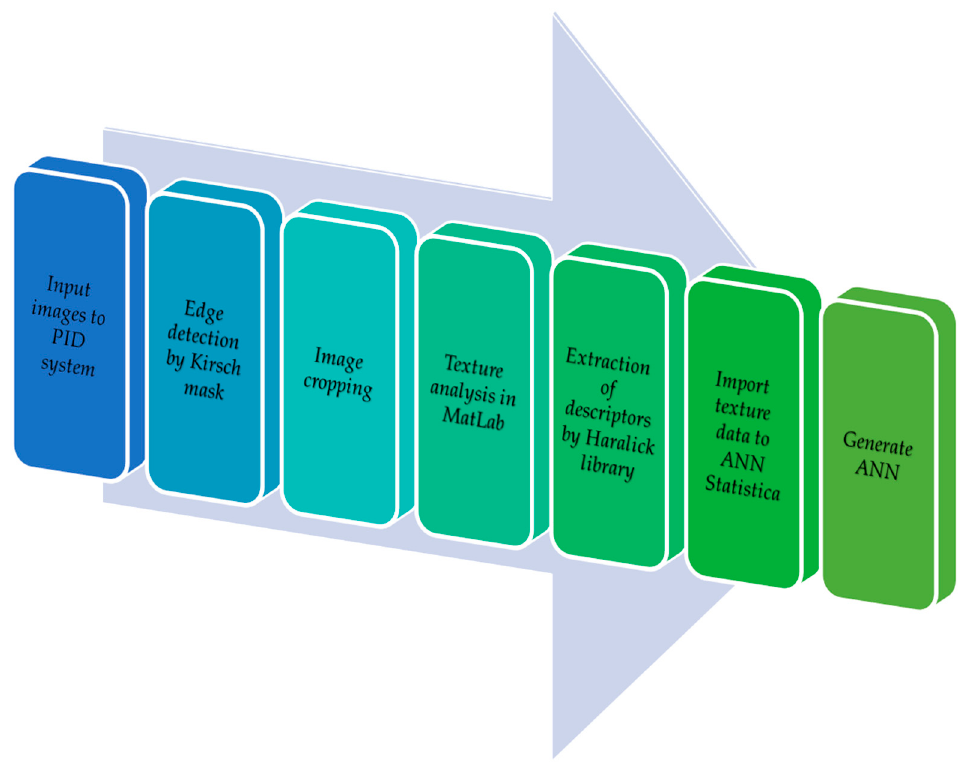
Figure 3. An image recognition algorithm.